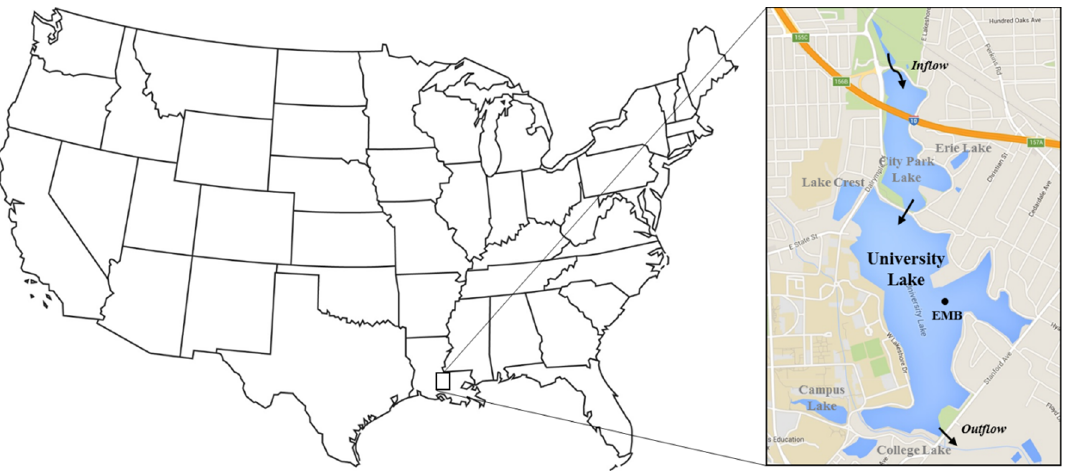
Figure 1. Geographical location of University Lake in Baton Rouge, Louisiana, USA and the permanently deployed Environment Monitoring Buoy (EMB) in the lake.